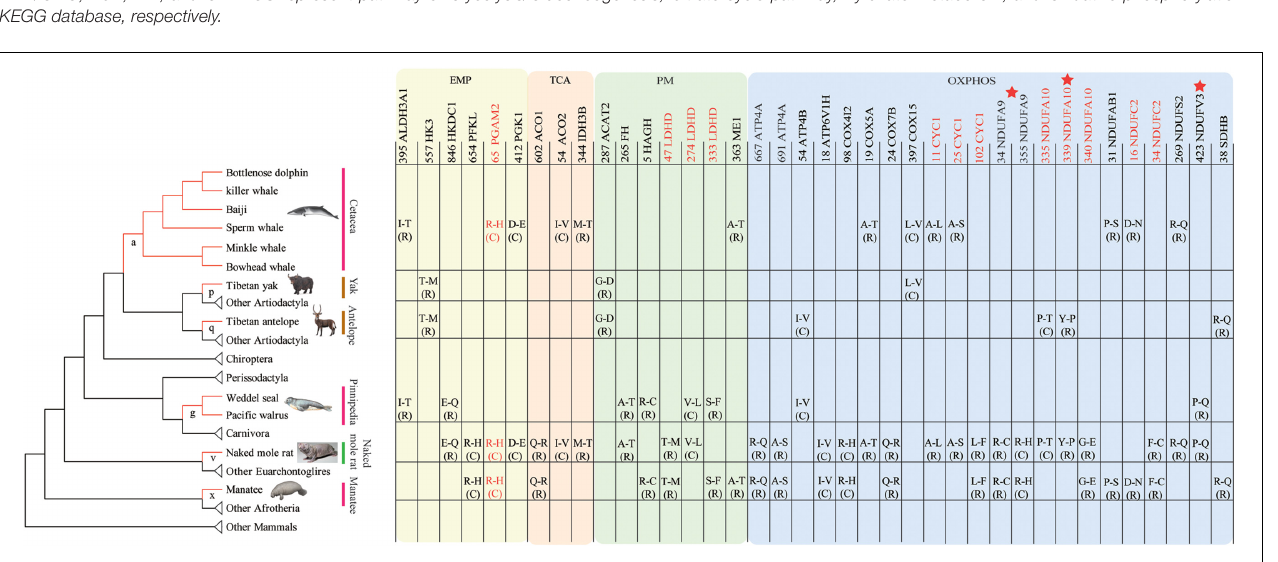
PSGs in pathway